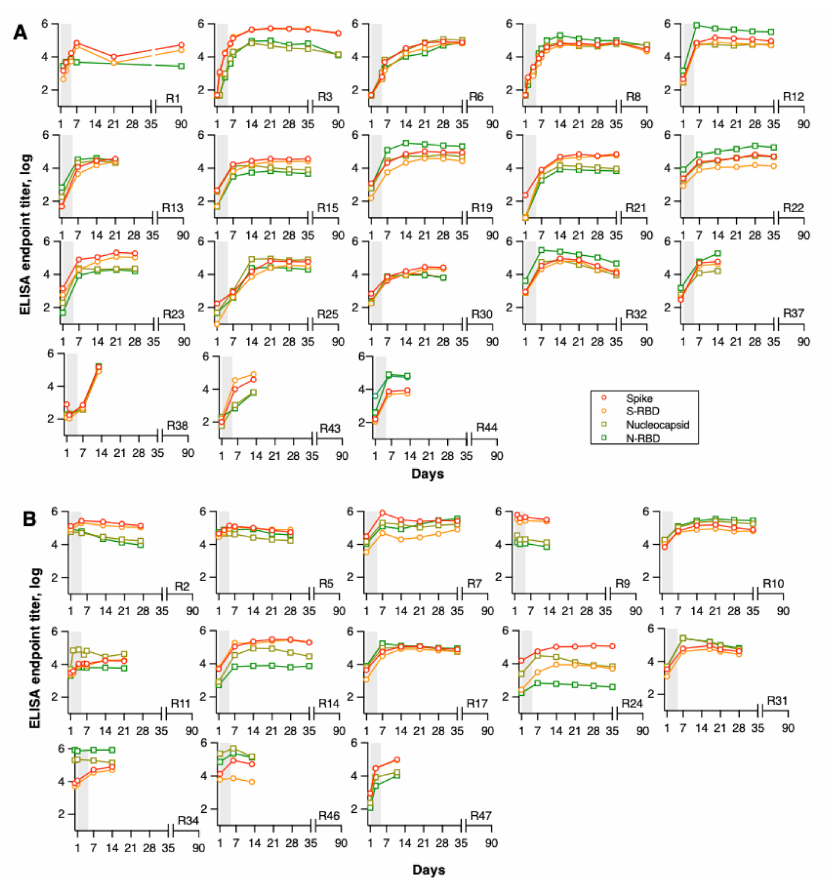
Figure 1. Kinetics of SARS-CoV-2 antibody development in COVID-19 patients treated with con- valescent plasma. Antibodies against Nucleocapsid, N-RBD, Spike, and Spike-RBD are plotted as endpoint titers for n = 31 patients at indicated timepoints. Patients were separated into two groups on the basis of antibody titers at day 1. ( A ) Patients ( n = 18) with low Spike (2.5 log) and spike-RBD (2 log) titers and ( B ) patients ( n = 13) with high Spike (4 log) and Spike-RBD (3.5 log). Grey shaded area marks the time of the 3 convalescent plasma transfusions.